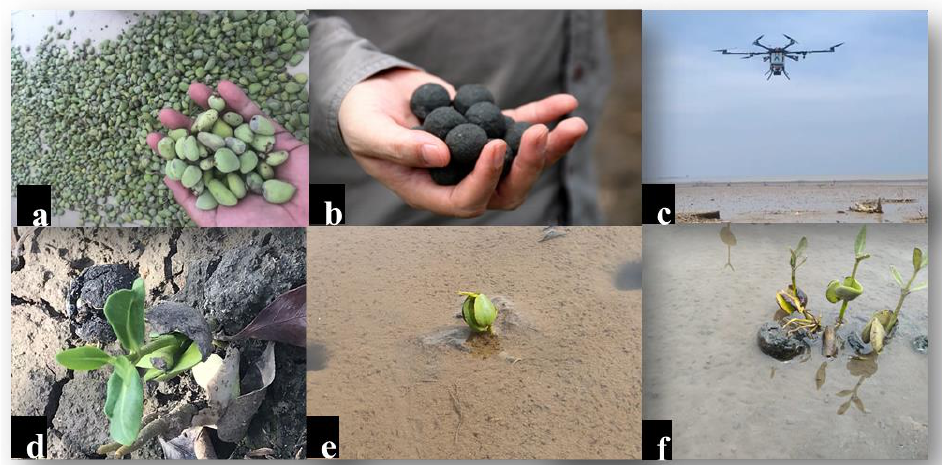
Figure 2. Advanced ecological-based mangrove rehabilitation techniques in order to accelerate successes and increase mangrove diversity with sowing seed balls by UAVs: ( a ) seeds of Avicennia marina; ( b ) mangrove seed balls; ( c ) UAV sowing seed ball system; ( d ) germination of A. marina seed balls in dry sediment; ( e ) germination progress of A. marina two weeks after sowing in wet sediment; ( f ) fast continuation germination of A. marina four weeks after sowing. (Documentation: Maman Turjaman and Consortium of Integrated Mangrove Sowing System).